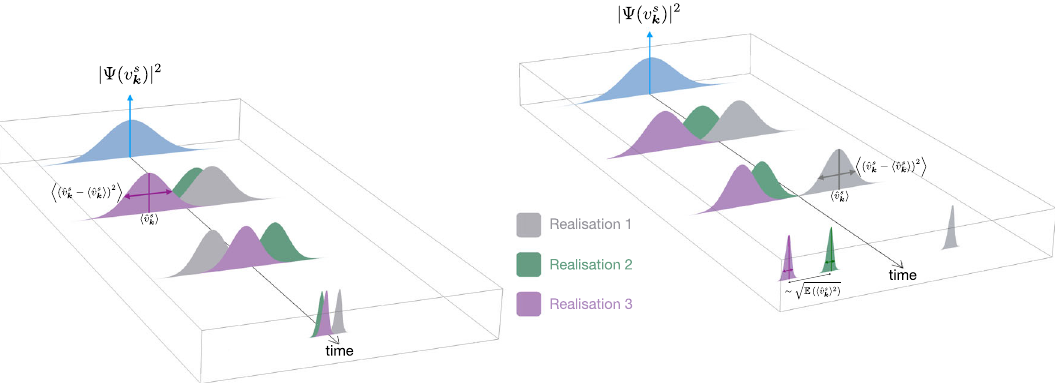
− (cid:4)ˆ v s (cid:2) ) 2 (cid:2)] , and our collapse k k